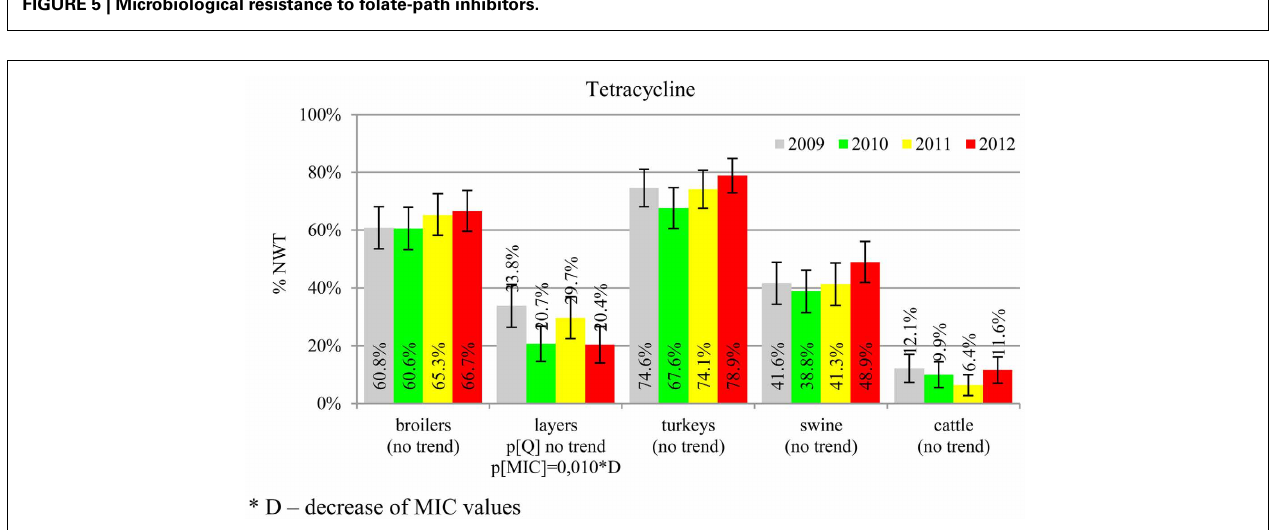
FIGURE 5 | Microbiological resistance to folate-path inhibitors.